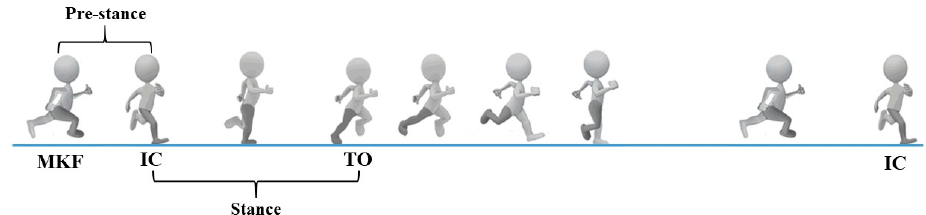
Figure 2. The phases of the running gait cycle. Note: MKF indicates maximum angle of knee flexion; IC indicates initial contact; TO indicates take-off; Pre-stance phase is defined as MKF to IC; Stance phase is defined as IC to maximum velocity of knee extension.